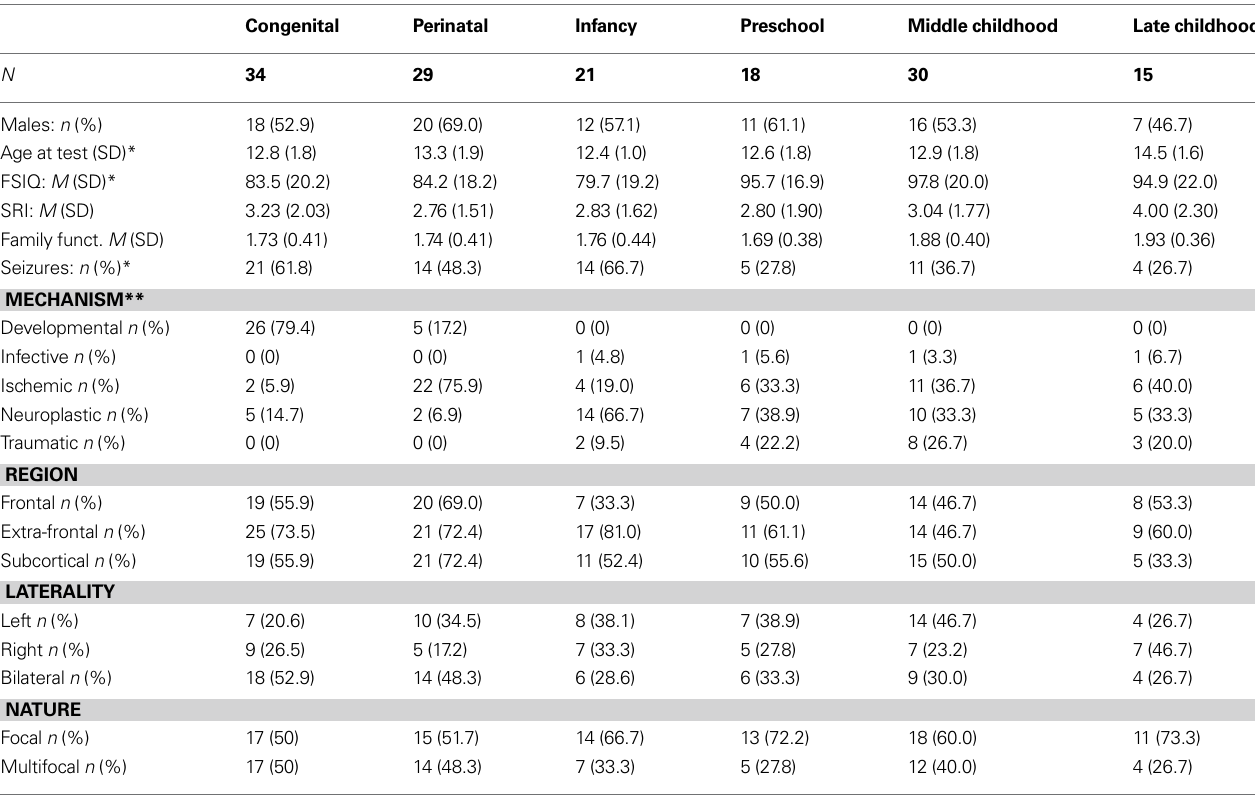
Table 1 | Characteristics for the sample across early brain insult groups.